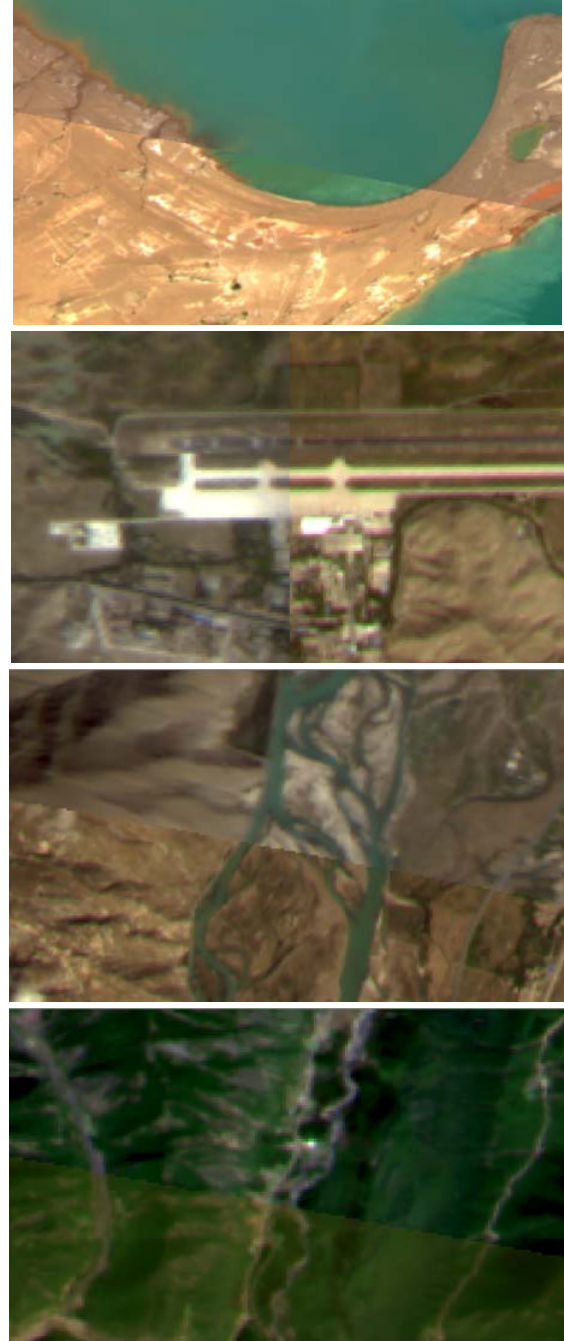
Figure 9. Screenshots of Tibet DOMs under condition